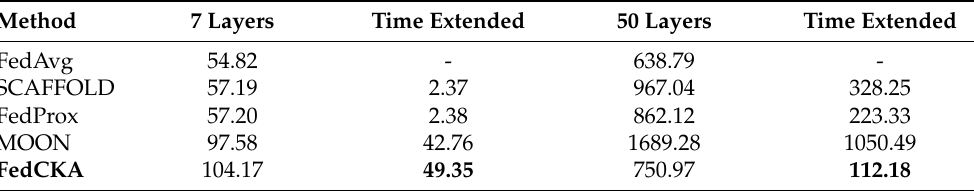
Table 4. Average Training Duration Per Communication Round (in